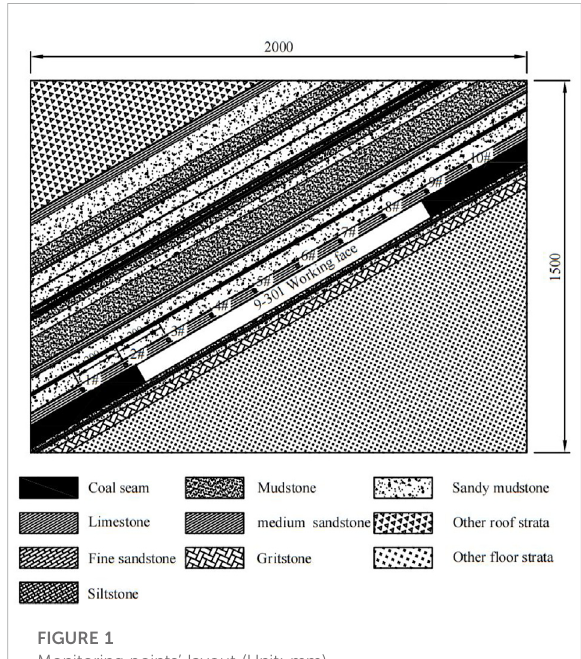
FIGURE 1 Monitoring points ’ layout (Unit: